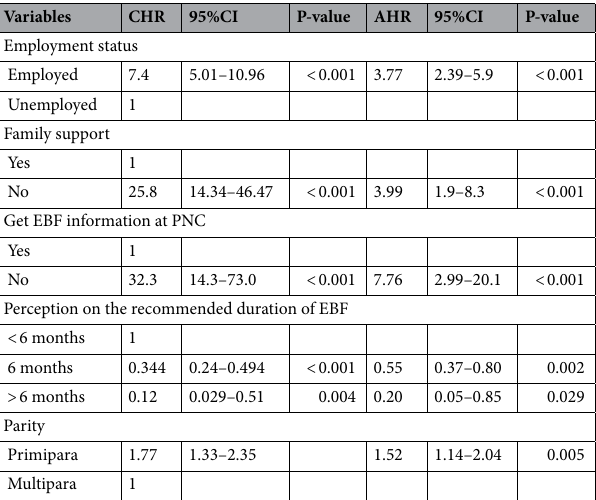
Table 7. Bivariate and multivariable cox proportional hazards model predicting the hazards of cessation of EBF among women who have 6–12 months’ age child in Debre tabor town, South Gondar zone, Northwest Ethiopia,